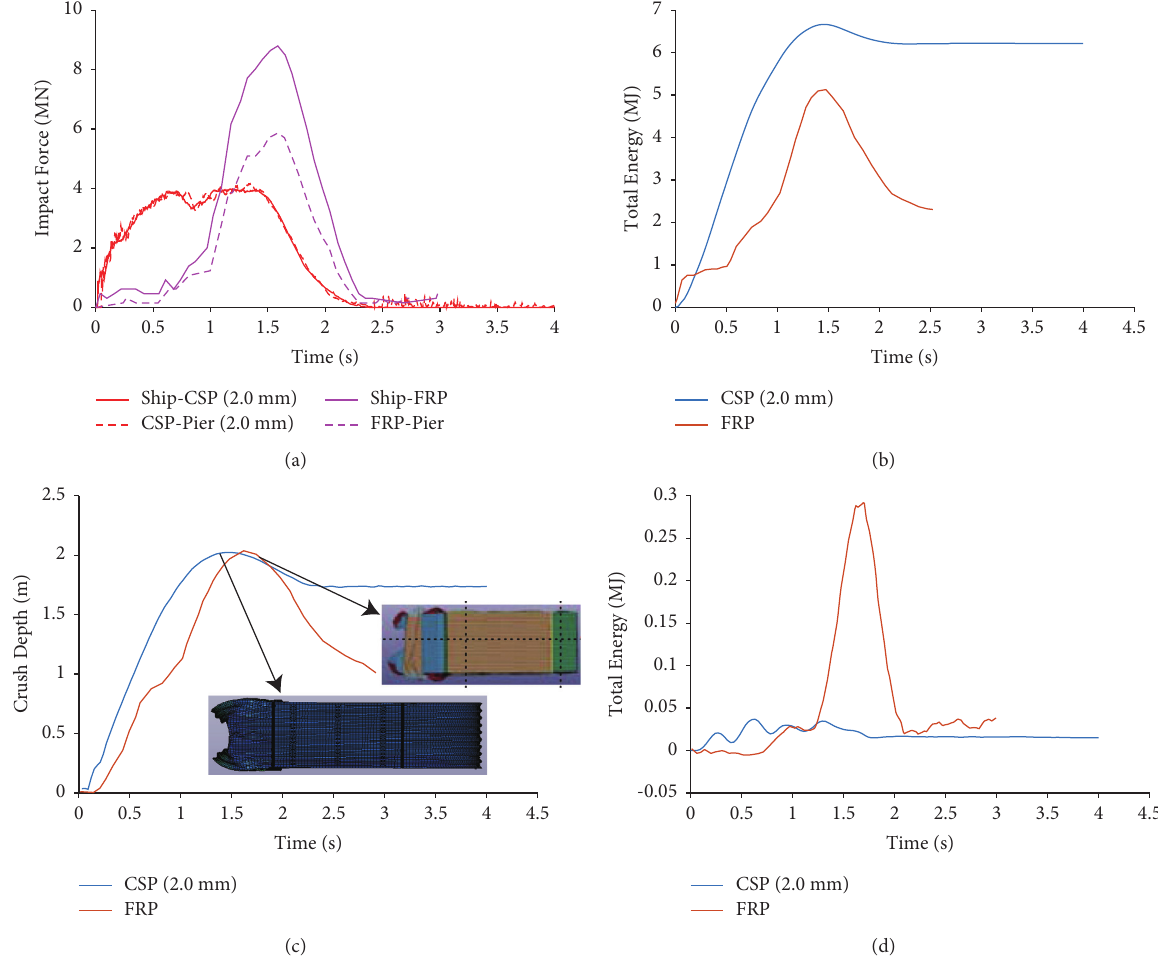
Figure 13: Time history curve of a barge hitting a CSP (2.50 mm) or a new FRP fender system head-on at 3 m/s: (a) impact force, (b) total energy of CSP, (c) impact crush depth of CSP or FRP, and (d) total energy of bridge